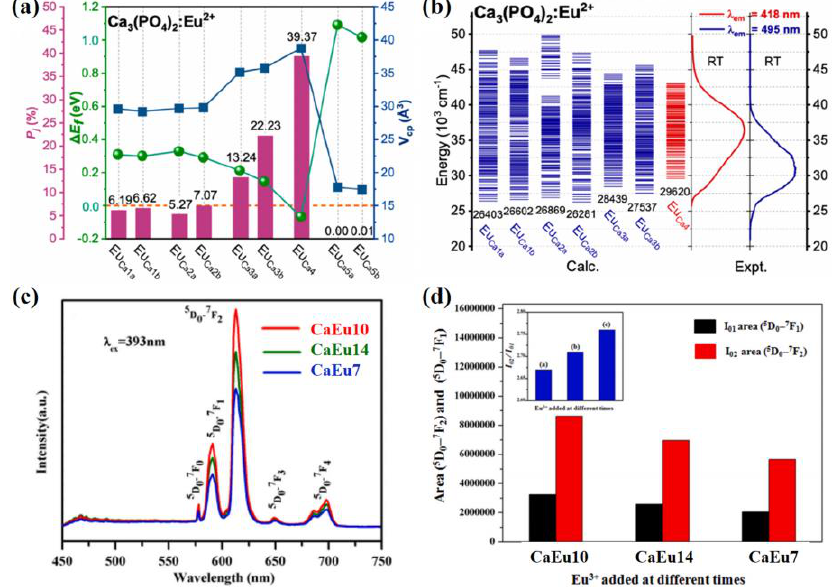
Figure 12. ( a ) Calculated defect formation energies ( ∆ E f ), occurrence probabilities ( P j ) and volumes of relaxed coordination polyhedra ( V cp ) for Eu 2+ substitutions at various Ca sites in Ca 3 (PO 4 ) 2 . ( b ) Schematic diagram for the calculated 4f 6 5d 1 energy levels of Eu 2+ in Ca 3 (PO 4 ) 2 . Reprinted with permission from ref. [95]. Copyright 2022 American Chemical Society. ( c ) The PL emission spectra. ( d ) area ( 5 D 0 - 7 F 2 ), area ( 5 D 0 - 7 F 1 ) and I 02 /I 01 (inset) for PL emission spectra of the series of CaCO 3 :Eu 3+ samples. Reprinted with permission from ref. [96]. Copyright 2021 Elsevier B.V.